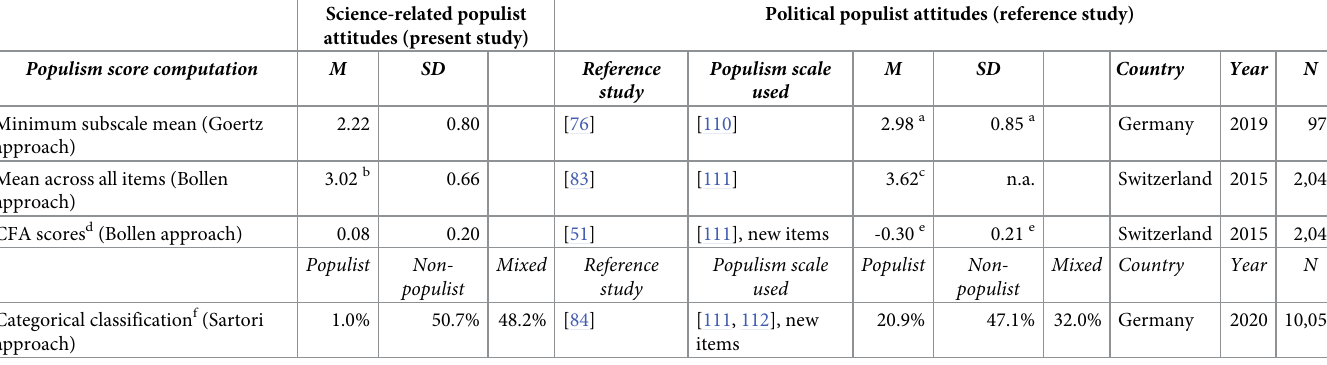
Table 1. Comparison of science-related populism scores (present study) and political populism scores (reference studies). Science-related populist attitudes (present